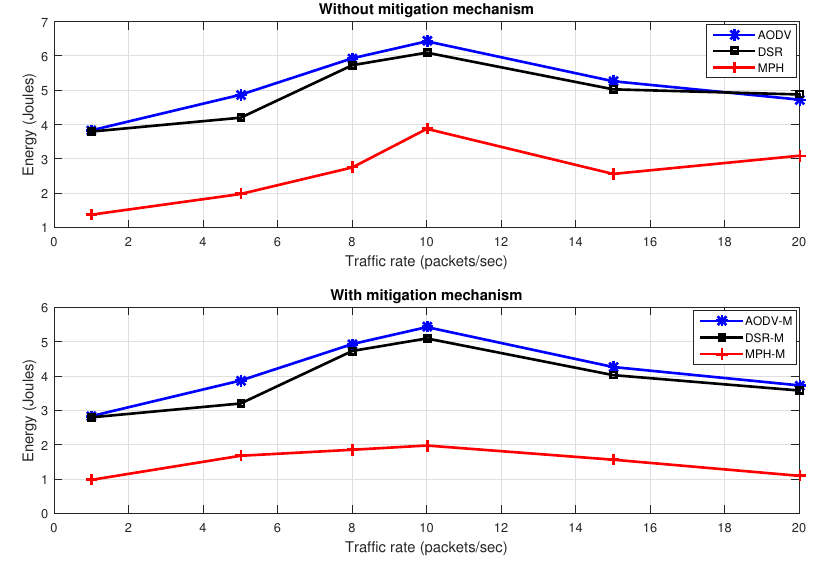
Figure 18. Energy consumption for different data rate for AODV, DSR, MPH, AODV-M, DSR-M and MPH-M under